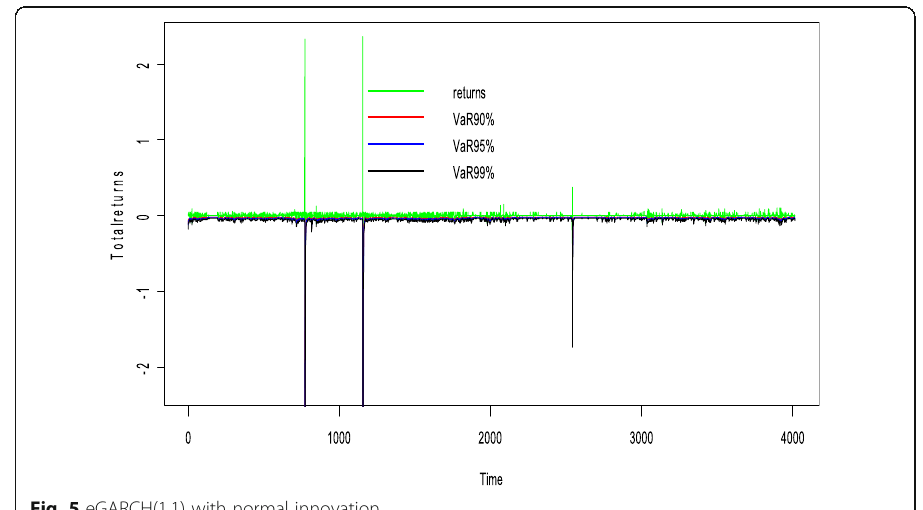
Fig. 5 eGARCH(1,1) with normal